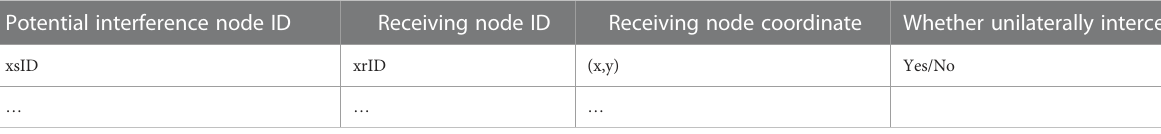
TABLE 2 Potential interference node list.